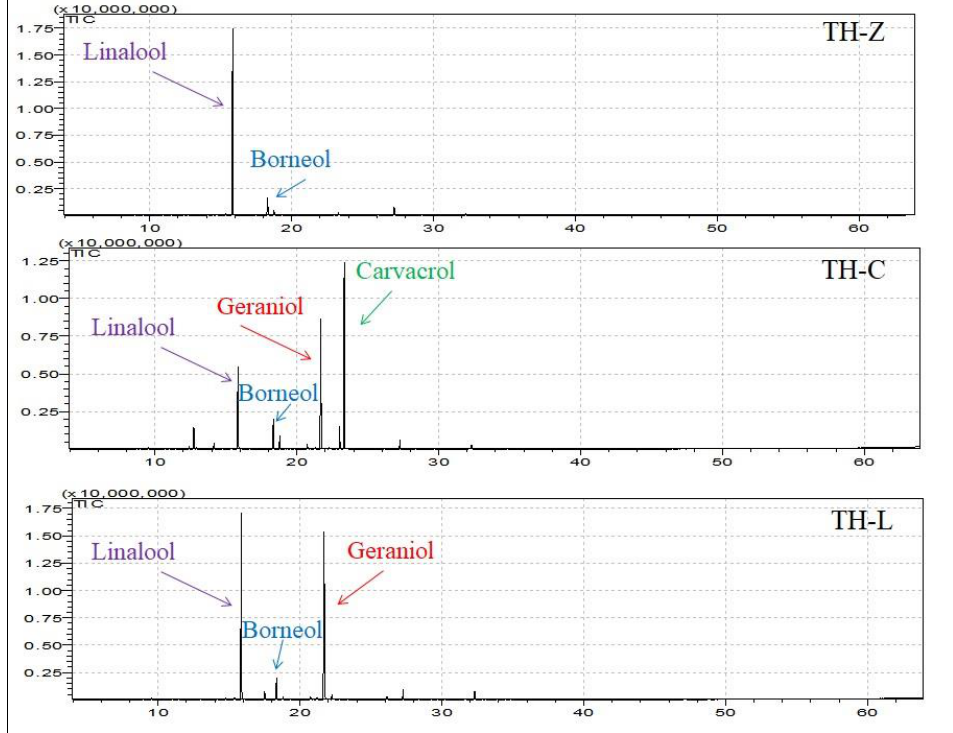
Figure 1. GC-MS chromatographs from the analysis of the essential oils of Thymus holosericeus collected from three Ionian Islands, Greece (TH-Z: Zakynthos; TH-C: Cephalonia, TH-L: Lefkada) during full-flowering (July 2018).